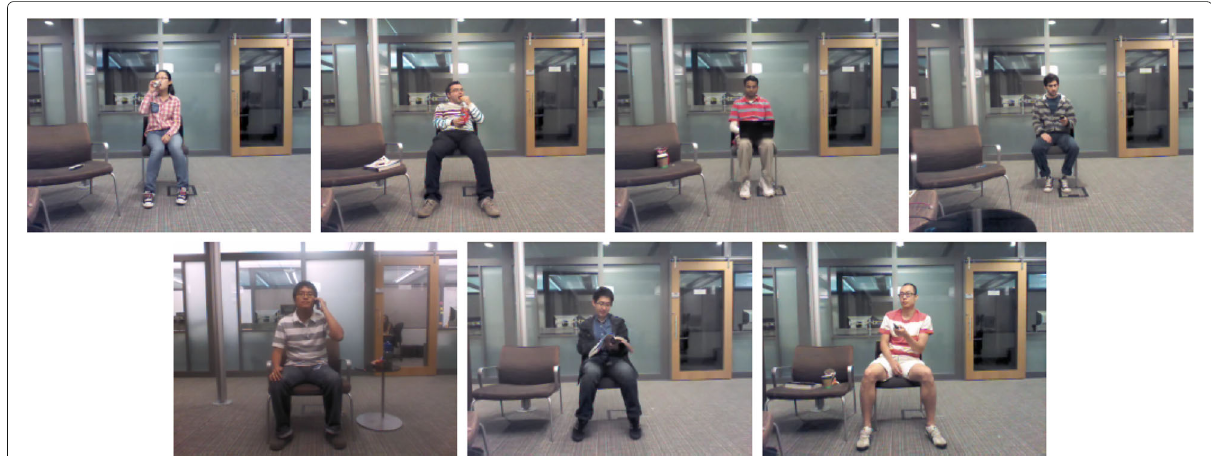
Fig. 5 Key frames from Dataset-B containing activities from 7 classes. Upper row from left to right: drinking , eating , usinglaptop , and reading cellphone . Lower row from left to right: makingphonecall , readingbook , and usingremote